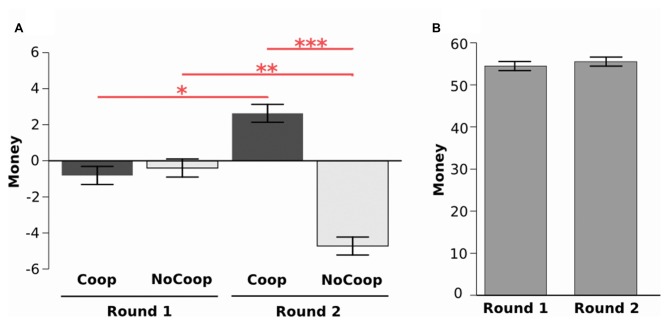
Results of Dictator game. (A) Distribution of money during two rounds for each confederate: cooperative (Coop) and non-cooperative (NoCoop). (B) Earnings in each of the two rounds. Bars represent the mean, and the error bars show the standard error. *p < 0.05, **p < 0.01, ***p < 0.001.